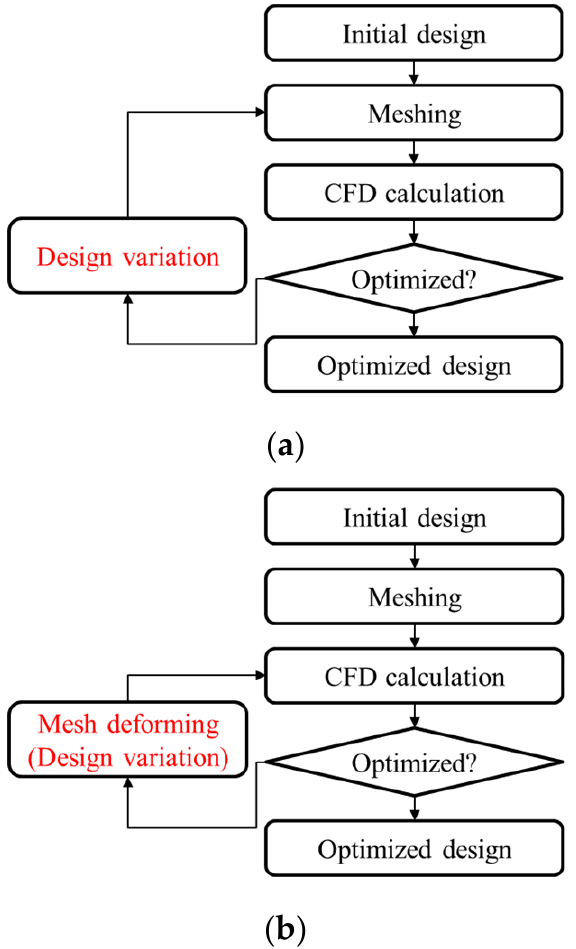
Figure 1. Procedure of computational fluid dynamics (CFD)-based optimization. ( a ) Re-meshing method. ( b ) Mesh deforming method.